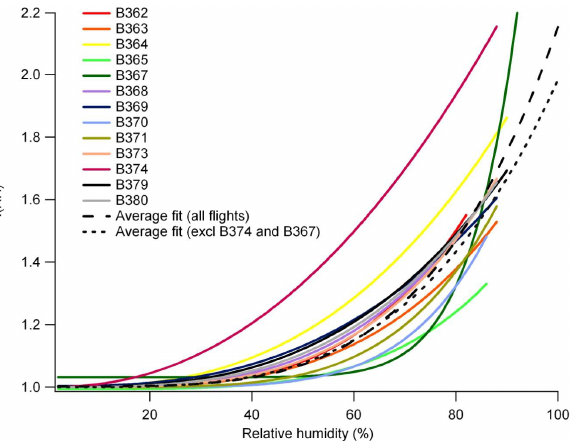
Figure 7. Growth curves derived from the wet nephelometer and averaged over each flight. 2 Fig. 7. Growth curves derived from the wet nephelometer and av- Solid dashed line - average fit calculated using all flights. Solid dotted line, average fit 3 eraged over each flight. Solid dashed line – average fit calculated excluding B374 and B367. 4 using all flights. Solid dotted line, average fit excluding B374 and